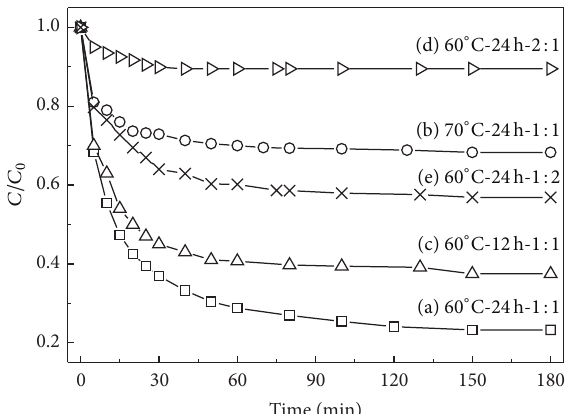
Figure 7: Removal efficiency of samples for MB (initial concentration 400 mg/L, pH = 7, and temperature 25 ∘ C).